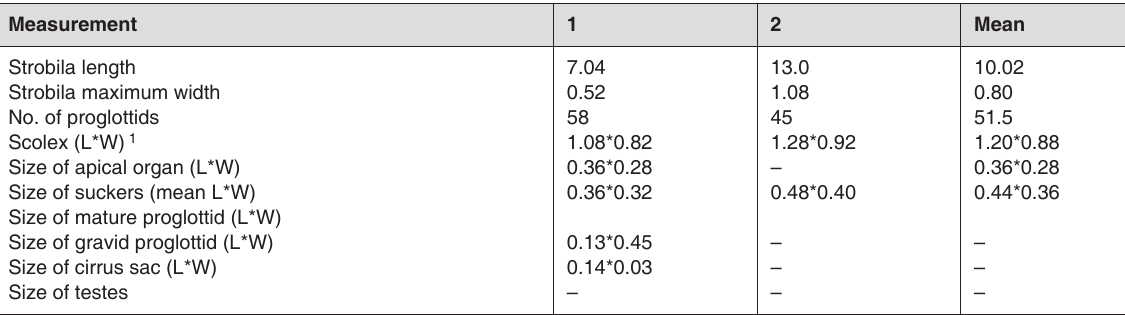
TABLE 3 Proteocephalus glanduliger measurements (in mm, unless otherwise stated) Measurement 1 2